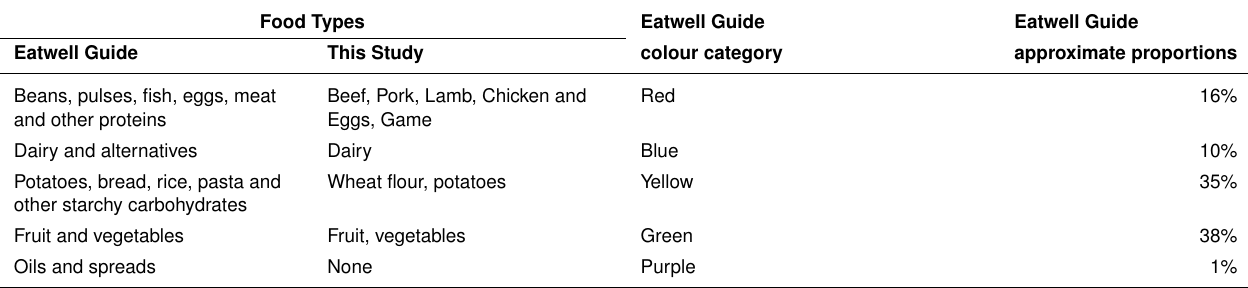
Table 3. Food types: The Eatwell Guide balanced diet [12] and this study.